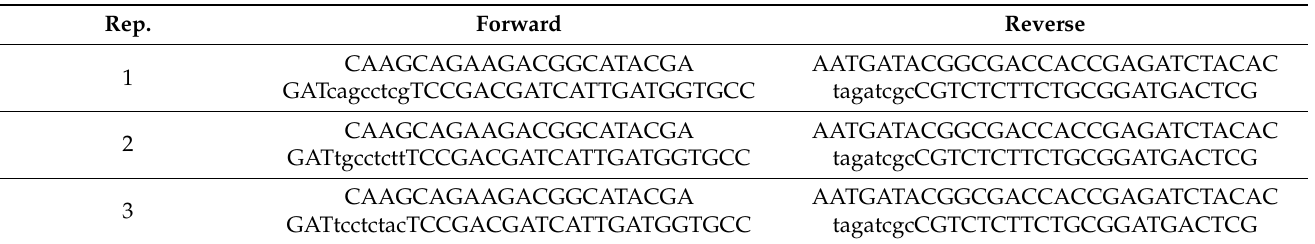
Table 2. Primer sequences for library amplification. The forward and reverse primers for library amplification per replicate are included in the table, and are listed in the 5 (cid:48) to 3 (cid:48) direction. The same reverse primer was used for each replicate however, a unique forward primer was used for